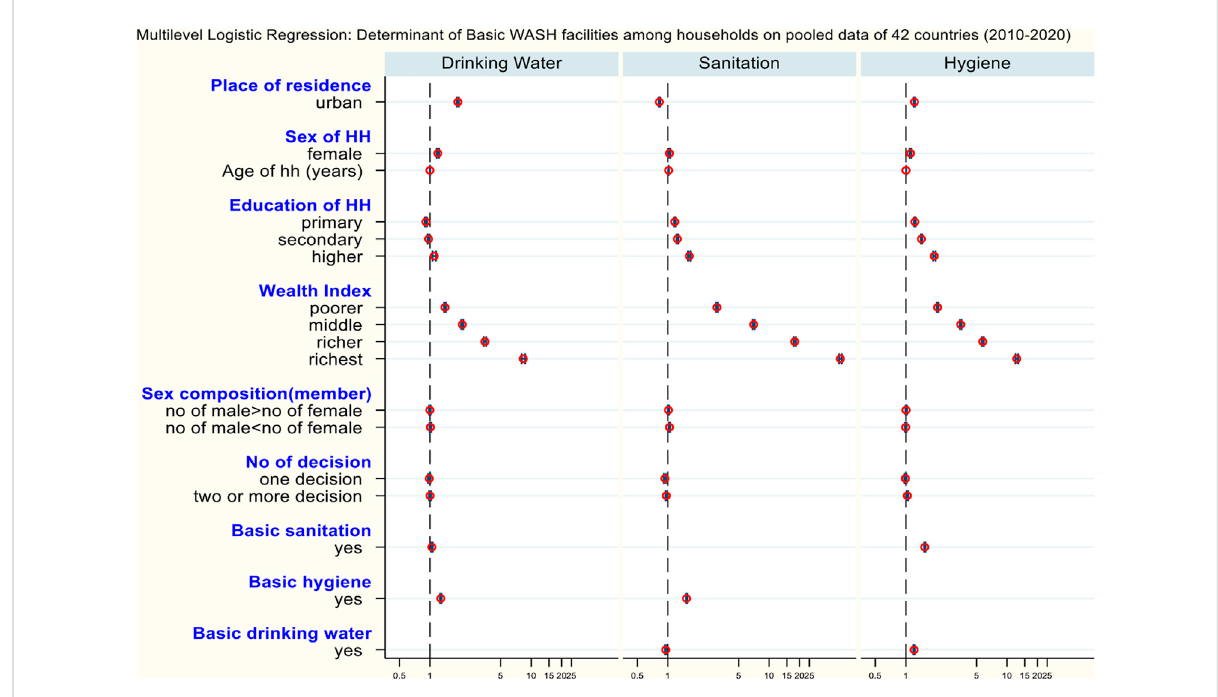
FIGURE 6 Multi-level Logistics determinants of Basic WASH facilities among households in pooled data of 42 countries (2010 –